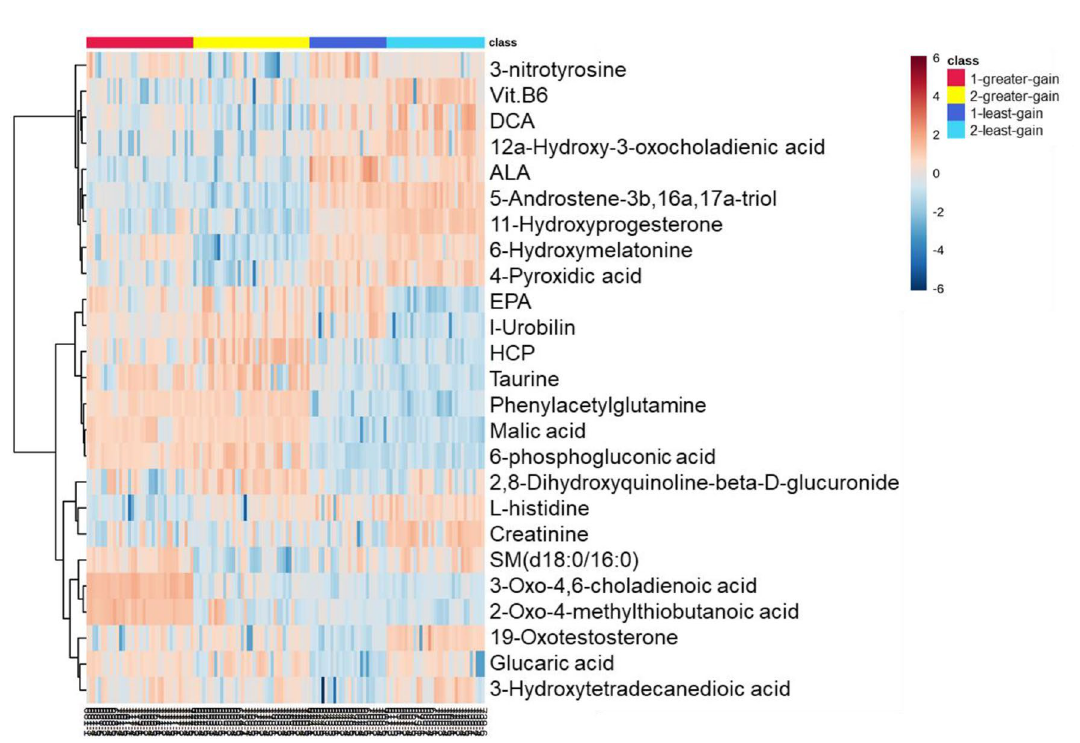
Figure 3. A heatmap representing the top 25 ANOVA metabolic changes in greater/least-ADG for stage 1 and stage-2 within 6 times point in stage 1 and stage 2. Dark-blue squares indicates a reduction of up to six folds, light-colors square indicates no significant fold change, and red square indicates an increase of up to six folds. ALA alpha-linoleic acid, DCA deoxicholic acid acid, EPA eicosapentaenoic acid, HCP heptacarboxyl